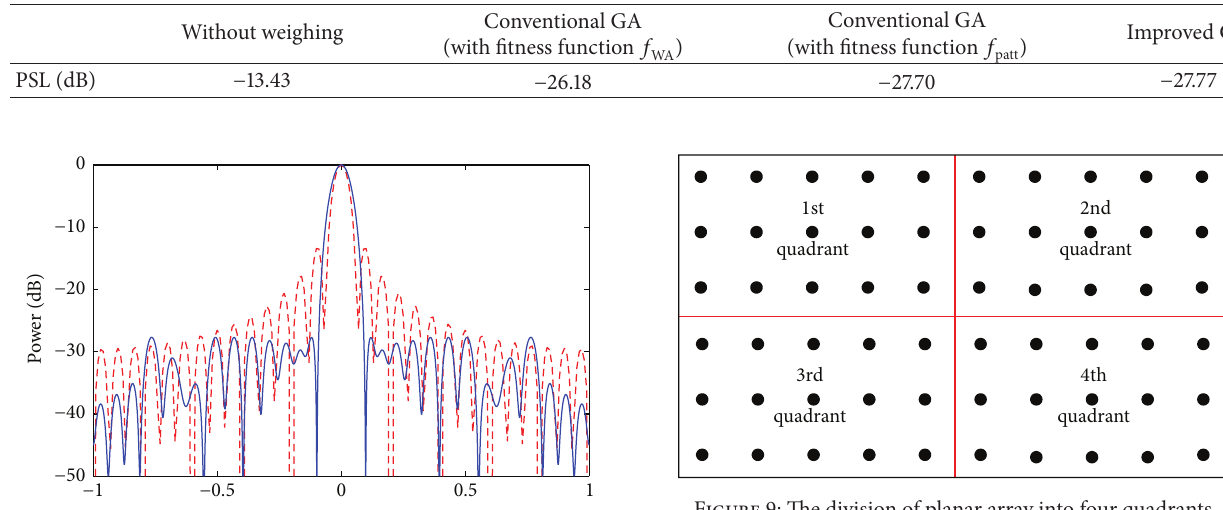
Table 2: The PLSs of sum beam with several approaches.